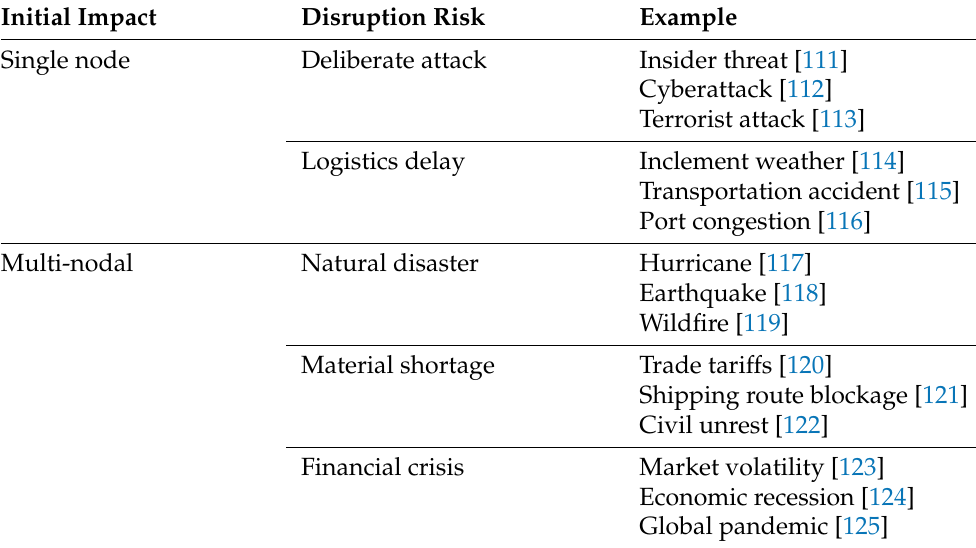
Table 1. Example disruption risks to supply chain networks